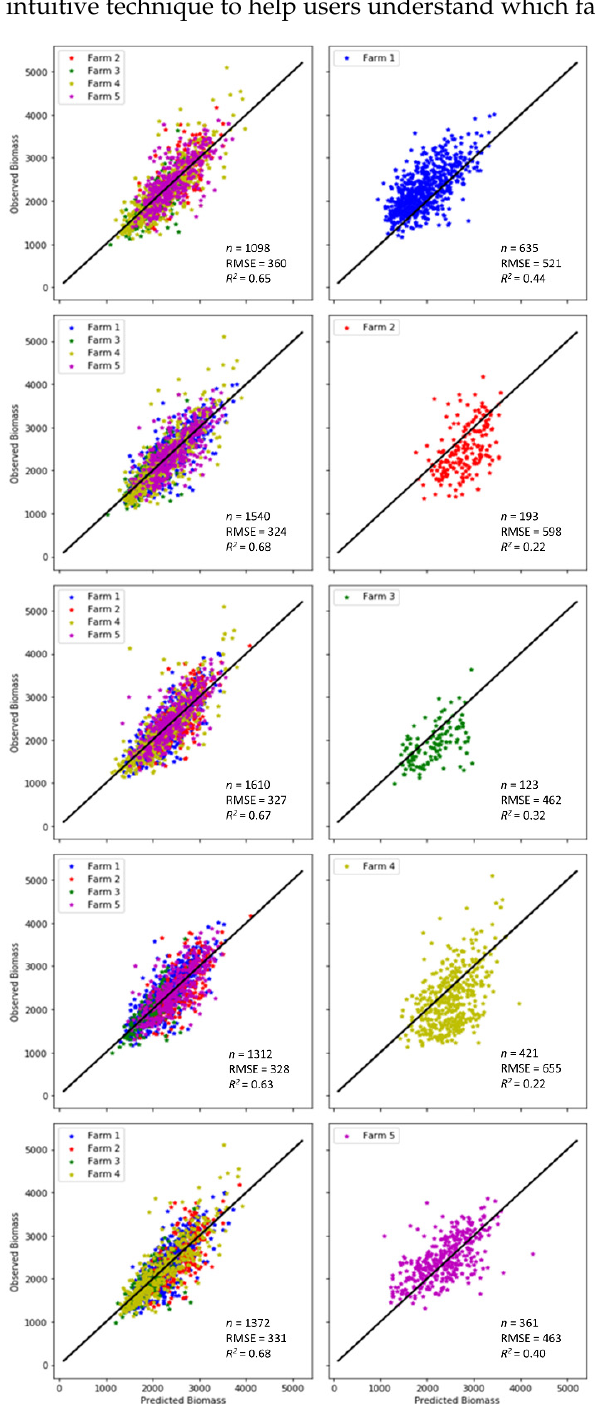
Figure 9. Observed vs. predicted biomass for the sensitivity analysis. In each line, data from one farm was removed from the dataset used in the calibration ( left ), and the resulting model was tested on that farm ( right ). The model used included data from S2 and the climate variables (experiment